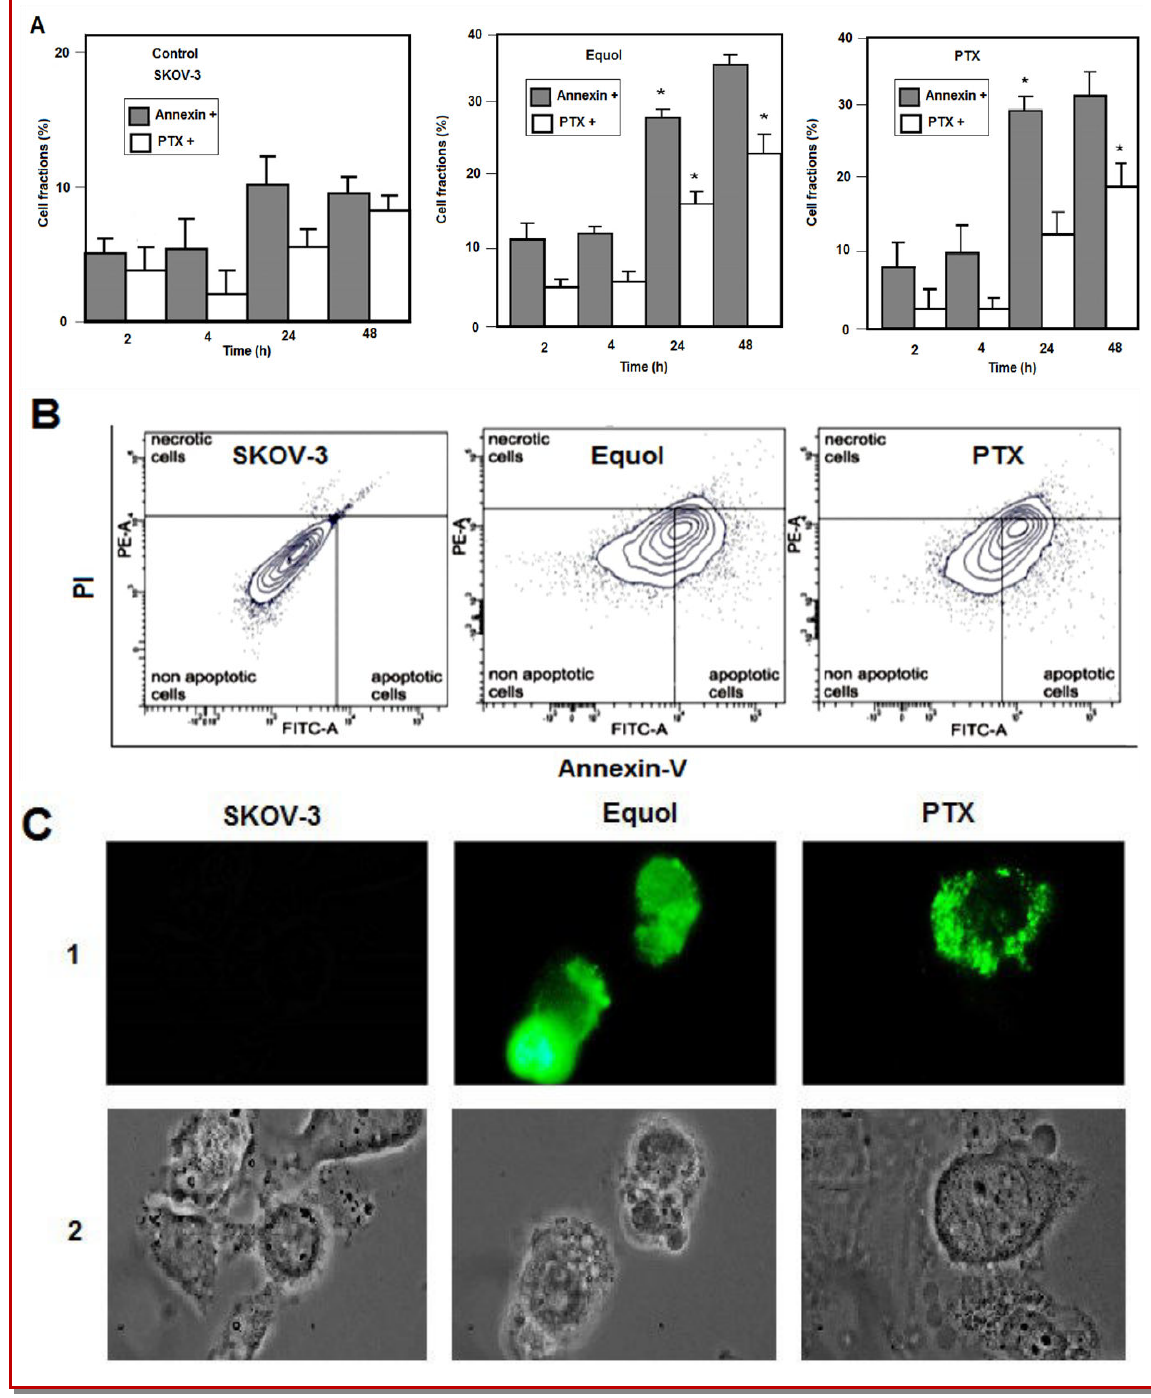
Figure 2 : Flow cytometric analysis. Apoptosis in SKOV-3 cells measured using an annexin V-FITC apoptosis detection kit. (A) Quantitative results of the effects of the drugs. (*) Statistically significant differences relative to control cells, taken as 100%, p< 0.05. (#) Statistically significant differences between samples incubated with equol and PTX, p<0.05. (B) Histograms for control cells and incubated with IC 50 of equol or PTX for 48 hours. (C) Fluorescence images of SKOV-3 control cells and incubated with equol or PTX (48 hours). Additionally, the images in contrast phase conditions were presented (panel